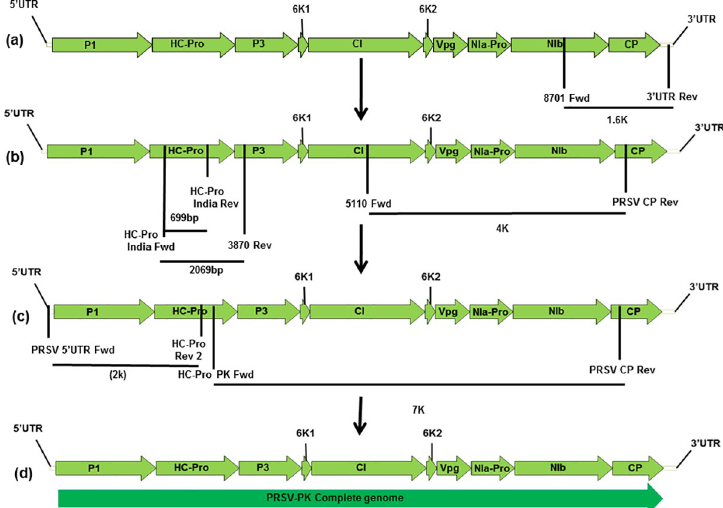
Fig 1. Schematic amplification of PRSV–PK genome. (a) CP gene amplification; (b) 4K, HC-Pro and full HC–Pro amplification; (c) 5’ terminal end and 7K amplification; (d) Full genome amplification. Open reading frames are indicated as arrows on viral sense RNA. The direction of arrow indicates the direction of translation. PI;HC-Pro; P3:; 6K1; CI: Cylindrical inclusions; 6K2; Vpg; NIa-Pro; NIb; CP: coat protein.